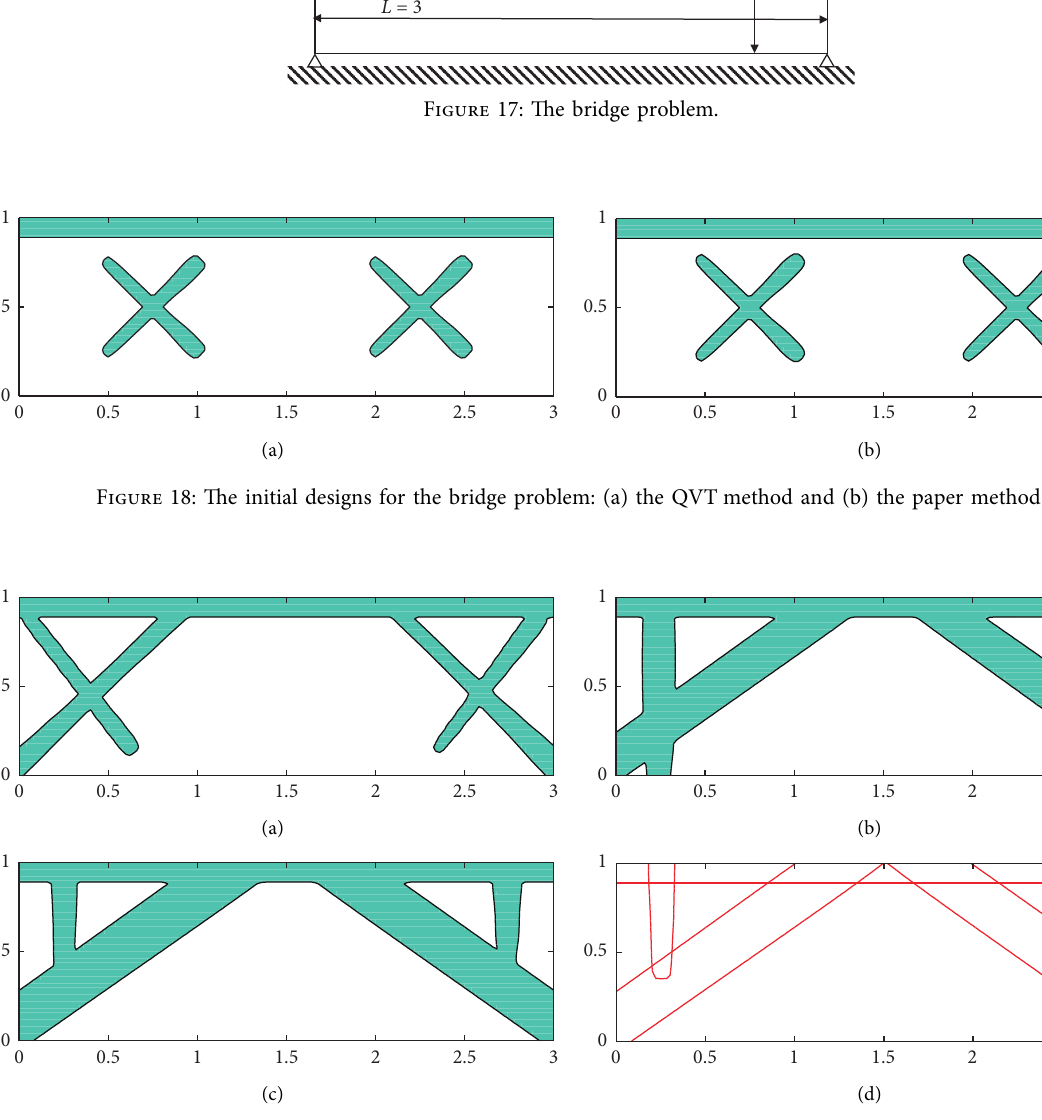
Figure 19: Some intermediate optimization results and the final results of the bridge example with the QVT method.